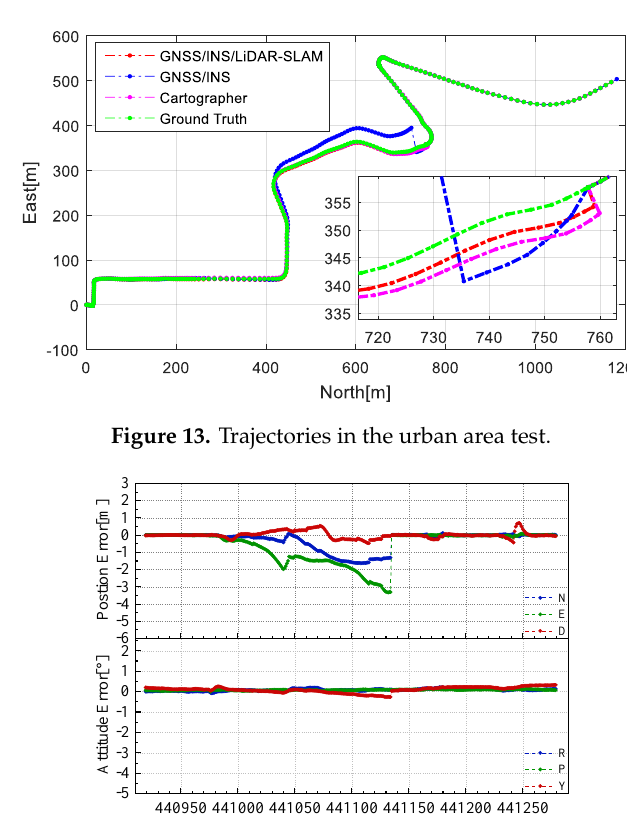
R P Y Figure 16. Position and attitude errors of Cartographer in the urban area test. T able 3 Error statistics for the urban area test. Position Error [m]